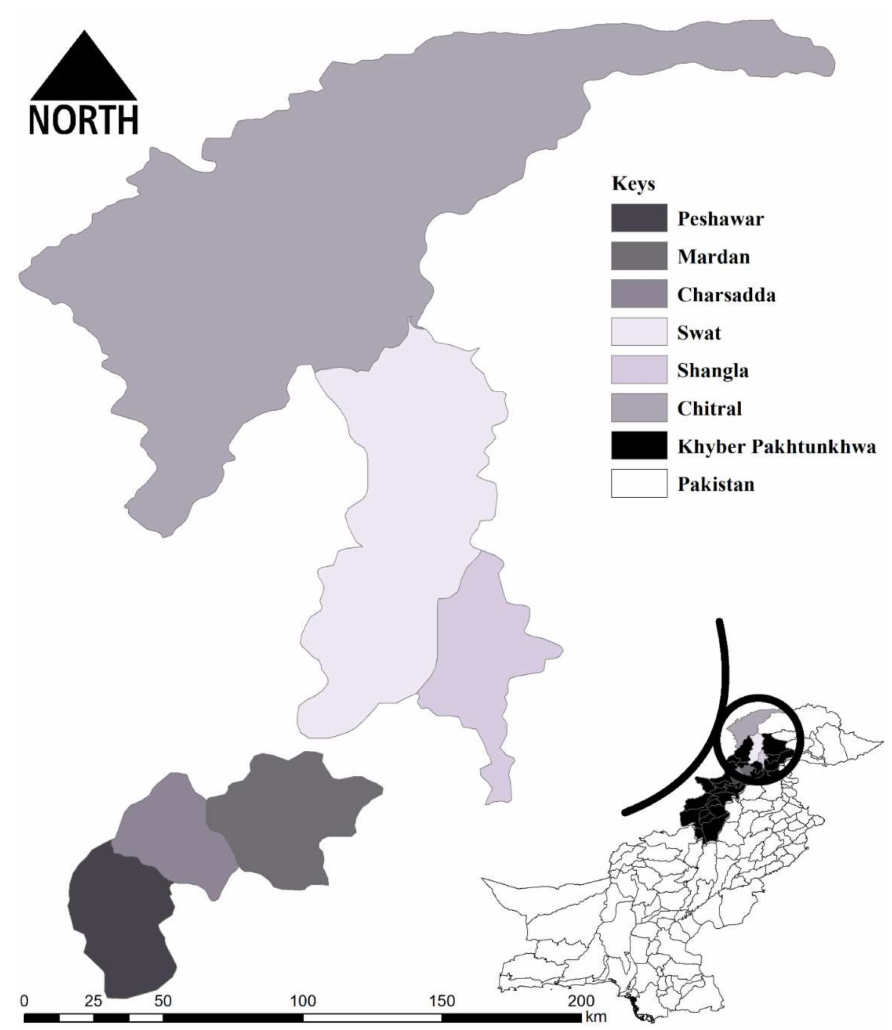
Figure 1. Map showing study districts where tick specimens were